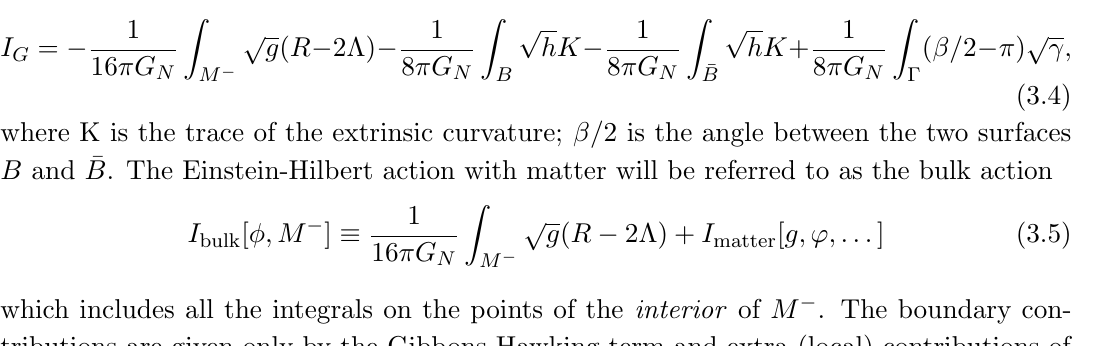
Figure 3. (a) The (cid:12)gure shows the state on a smooth (initial) surface (cid:6); while (cid:12)gure (b) depicts the projection on a basis to a non-smooth surface (cid:6), in this case the (Euclidean) path integral that represents the wave functional requires a Hayward term in the